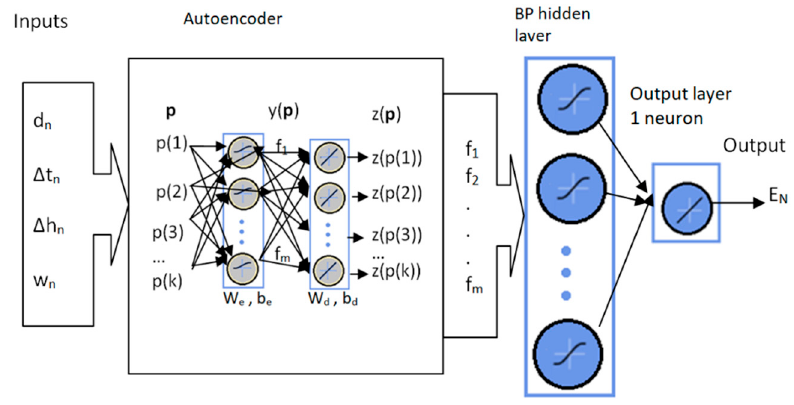
Figure 7. Autoencoder stack and multilayer perceptron (MLP) of the energy consumption estimation DLN.